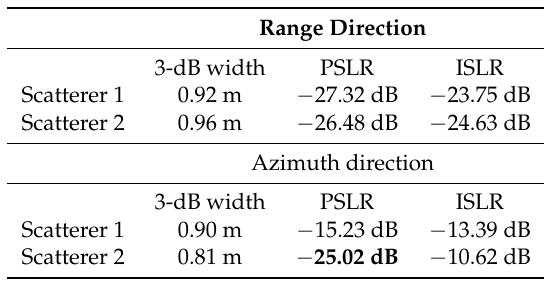
Figure 16. Comparison of zoom-in SAR image by the ω K-based MoComp algorithm (left images) and the proposed algorithm (right images). Table 2. Focusing quality of the ω K-based MoComp